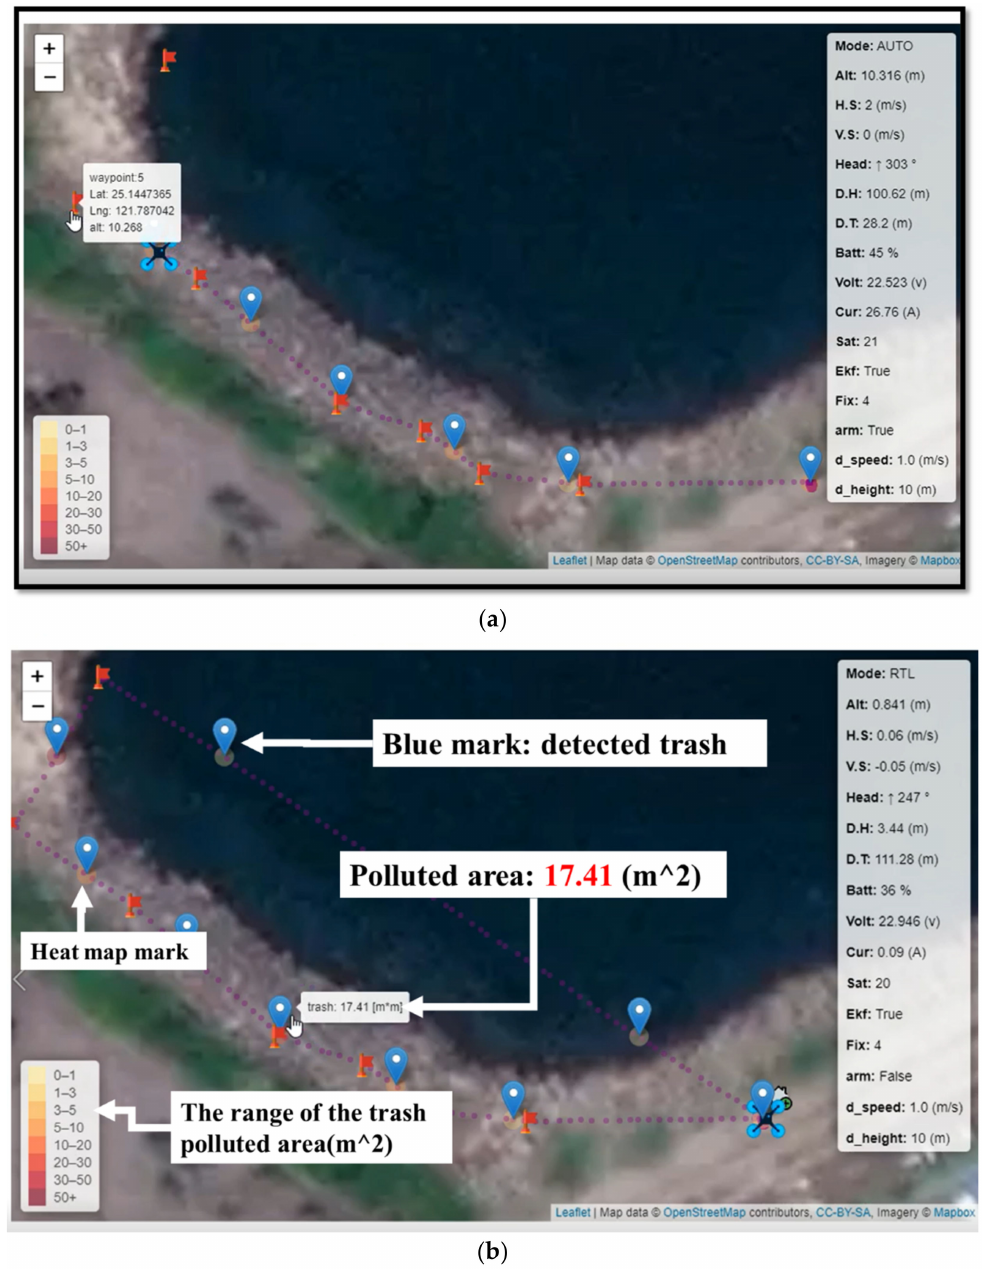
Figure 15. Trash and the unmanned aerial vehicle (UAV) information on the trash monitoring system. ( a ) A UAV map to monitor the UAV waypoints and the status in the Badouzi fishing port. ( b ) A UAV map to monitor the trash detection and the trash polluted area in the Badouzi fishing